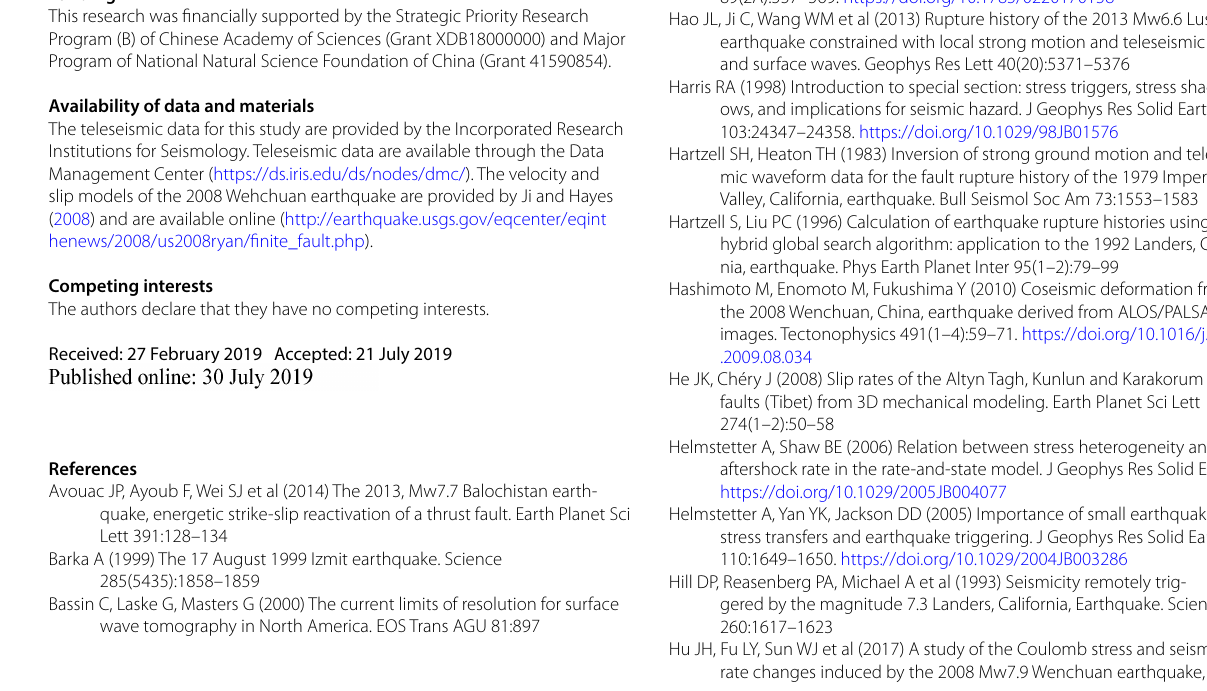
Additional file 1: Fig. S1. Fit error of different focal mechanisms for the 2017 Jiuzhaigou earthquake. Fig. S2. Fit error of different focal mecha- nisms for the 2013 Lushan earthquake. Fig. S3. Fit error of different depths for the 2017 Jiuzhaigou earthquake (strike150°, dip78°, rake-13°). Fig. S4. Fit error of different depths for the 2013 Lushan earthquake (strike212°, dip42°, rake100°). Fig. S5. a . Map of relocated sequence of the 2013 Lushan earthquake, b . depth cross section along AA’. The red dots denote aftershocks, whereas the main-shock is represented with the black star. Fig. S6. Histograms of aftershocks as the function of the value of stress change. a . The 2017 Jiuzhaigou earthquake and b . The 2013 Lushan earthquake. Fig. S7. Stress changes imparted caused by the 2013 Lushan earthquake. a maximum Coulomb stress change, b stress change of the cross-sectional AB in a . Fig. S8. Stress changes imparted by the 2008 Wenchuan earthquake calculated with various depths and effective friction coefficients. a , b and c are the calculations with effective friction coefficient of 0.0, 0.4 and 0.8 at 14 km depth, respectively. d , e and f are the calculations with effective friction coefficient of 0.0, 0.4 and 0.8 at 9 km depth, respectively. The yellow star and black stars are the epicenters of the Wenchuan, Jiuzhaigou and Lushan earthquakes, and black circles denote the Wenchuan earthquake 1 day M L > 4 aftershocks. Fig. S9. Shear and normal stress changes imparted by the 2008 Wenchuan earthquake. a , b are the calculations at 9 km depth. c , d are the calculations at 14.4 km